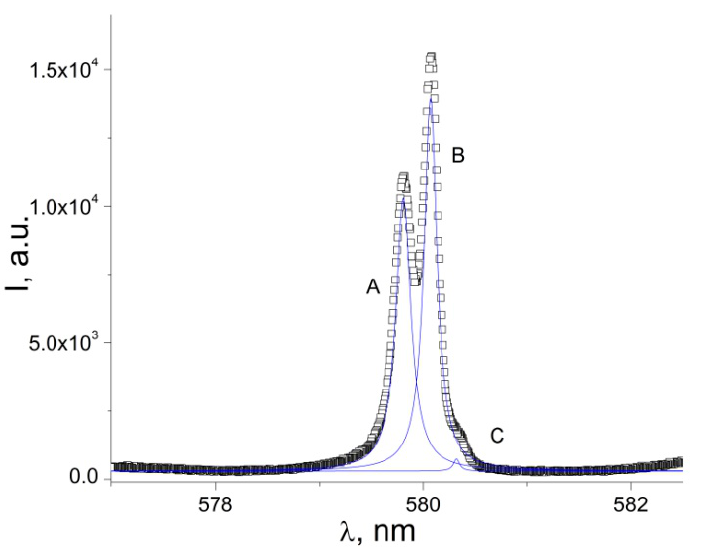
Figure 5. High-resolution emission spectrum for the 5 D 0 → 7 F 0 transition at 300 K and its deconvolu- tion, λ exc = 405 nm.